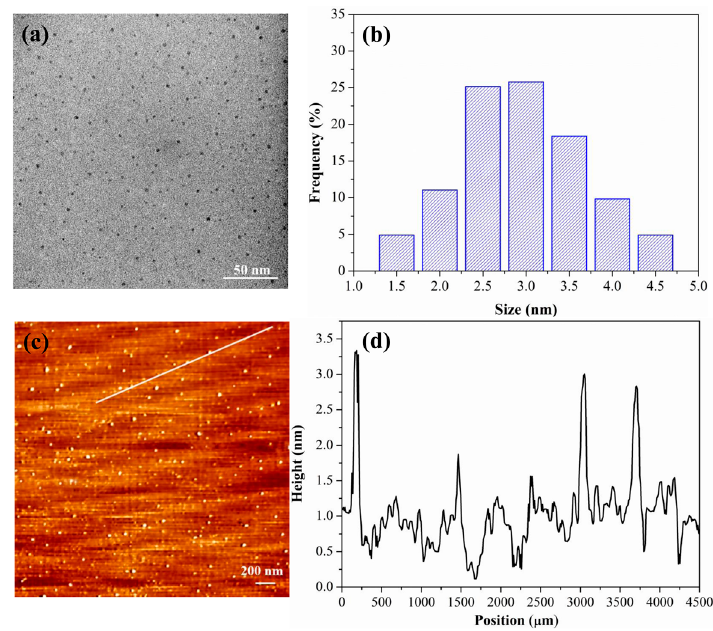
Figure 1. Transmission electron microscopy (TEM) image ( a ) and the size distribution ( b ) of PCDs; Atomic force microscope (AFM) image on mica substrates ( c ) with the height profile along the line in the image ( d ) of PCDs.